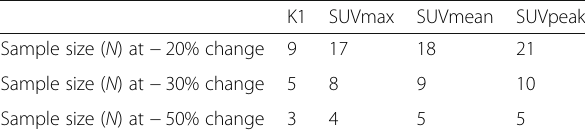
Table 3 Sample size implications of tumor blood flow repeatability from the present study. Calculations were performed to detect relative changes of − 20%, − 30%, and − 50% using a two-sided significance test for paired data with a significance level of 5% and a power of 95%. Log-transformed data were used for all calculations